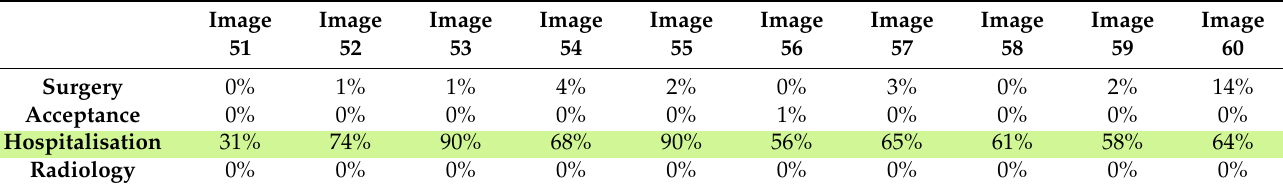
Table 12. Results obtained with the second version of the customised model for the “hospitalisation” IU. Each column refers to one of the test images (51 to 60) and each row shows the labels that were returned by the model. The row–column intersection shows the success rate in recognising the concept stated in the row for the image in that